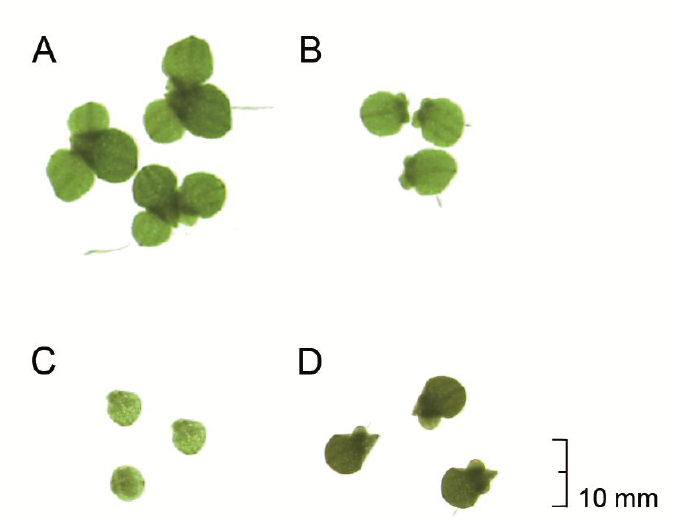
FIGURE 3. Duckweed ( L. gibba L.) fronds (leaves): (A) unimpaired (healthy) fronds, (B) arsenic(V)-impaired fronds as used in the experiments.